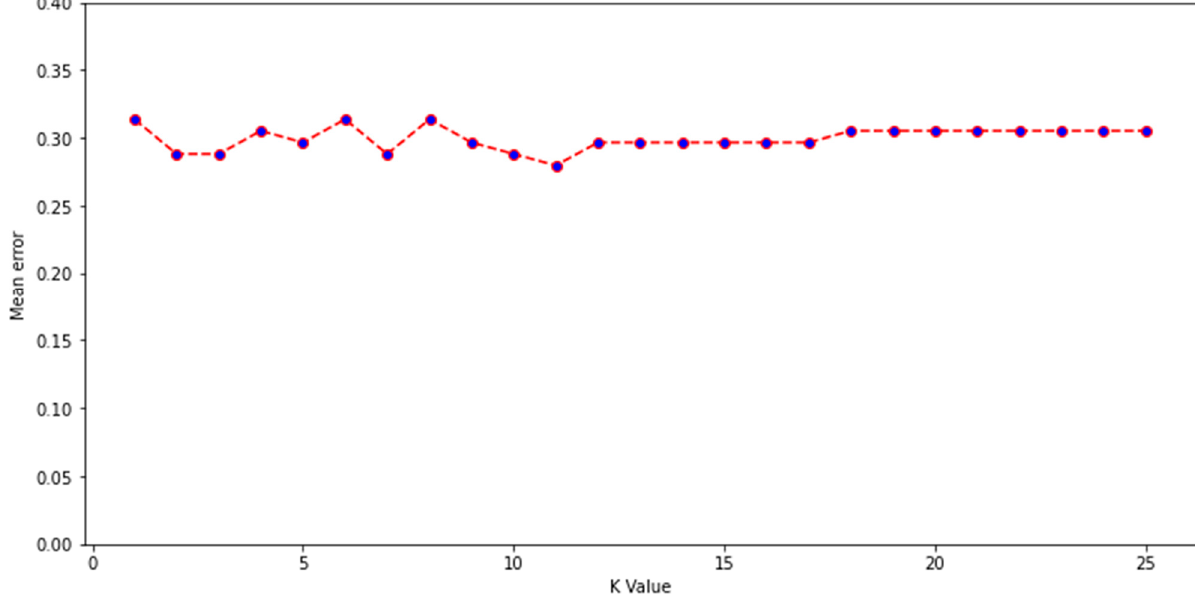
Figure 1. Mean error for K values of 1–25 during construction of a K-nearest neighbour algorithm developed to label unlabelled drugs.